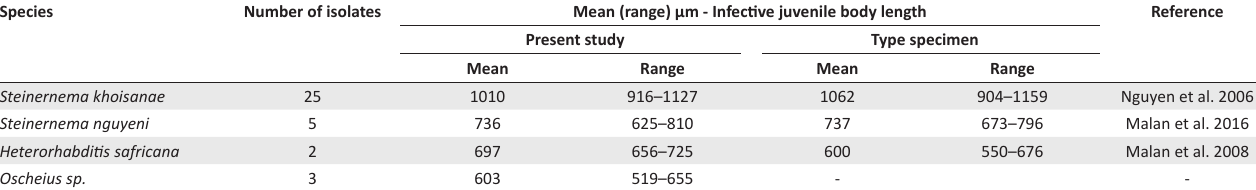
TABLE 3: Measurements of the body length of the infective juveniles.